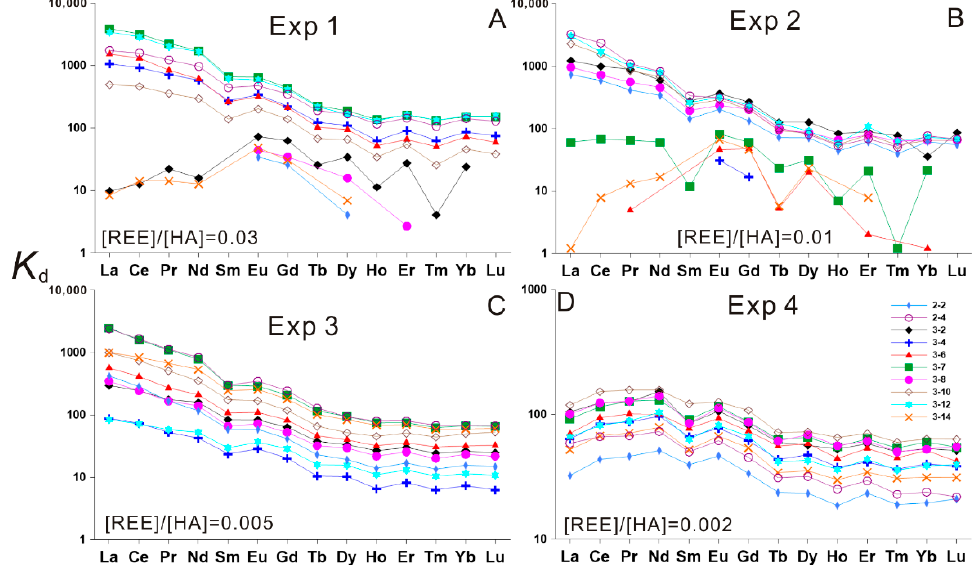
Figure 5. REE distribution pattern of K d obtained at 150 °C and various [REE]/[HA] ratios. ( A ), Experiment 1, performed at a [REE]/[HA] concentration ratio of 0.03 ([REE]/[HA] = 0.03); ( B ), Experiment 2, performed at [REE]/[HA] = 0.01; ( C ), Experiment 3, performed at [REE]/[HA] = 0.005; ( D ), Experiment 4, performed at [REE]/[HA] = 0.002 .